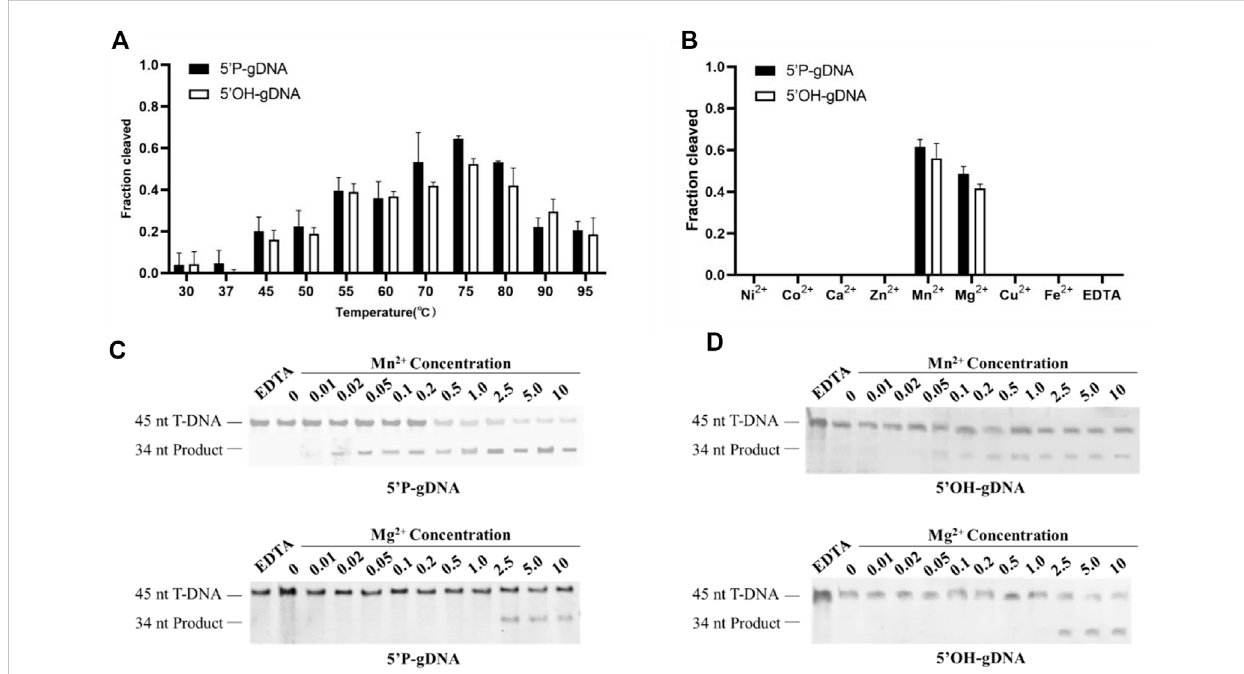
FIGURE 2 Effects of temperatures and divalentcations on TtdAgo activity. (A) Temperature dependence of DNA cleavage by Ttd Ago using 5 ′ -P-gDNAand 5 ′ - OH-gDNA. The assay in (A) was performed in the reaction buffer containing 5 mM Mn 2+ ions atindicated temperatures. (B) Effects of different cations on DNA cleavage activity mediated by 5 ′ -P-gDNA and 5 ′ -OH-gDNA. The concentration of divalent cations is 5 mM. (C) Effects of Mn 2+ concentration and Mg 2+ concentration on DNA cleavage activity mediated by 5 ′ -P-gDNA (D) Effects of Mn 2+ and Mg 2+ concentrations on DNA cleavage activity mediatedby5 ′ -OH-gDNA.Theassay in (B, C,D) wasperformedat75 ° C for30 min underdifferentdivalentmetal ions.All reactionswerecarriedoutwith Ttd Ago, guide, and target at the molar ratio of 4:4:1 (800 nM Ttd Ago preloaded with 800 nM guide, plus 200 nM target) with 18-nt